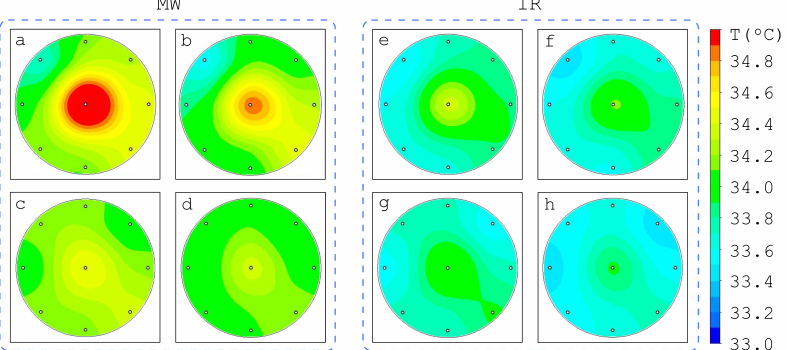
Figure 16. Brightness and infrared temperature distributions of three models with different tumor sizes: ( a , e ) R = 1 cm; ( b , f ) R = 0.75 cm; ( c , g ) R = 0.5 cm. The models in panels ( d , h ) do not contain tumors.